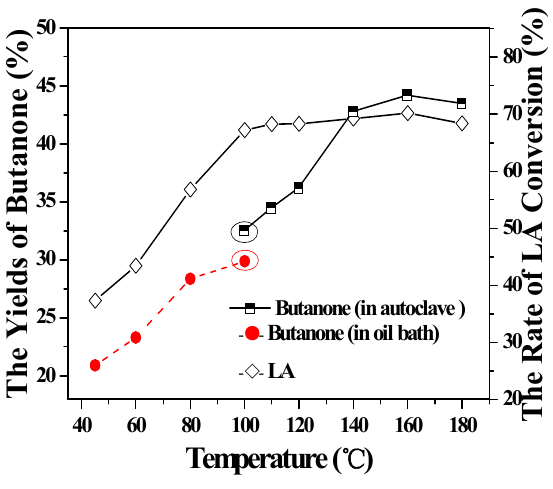
PO ; pH: 5.0; time: 0.5 2 4